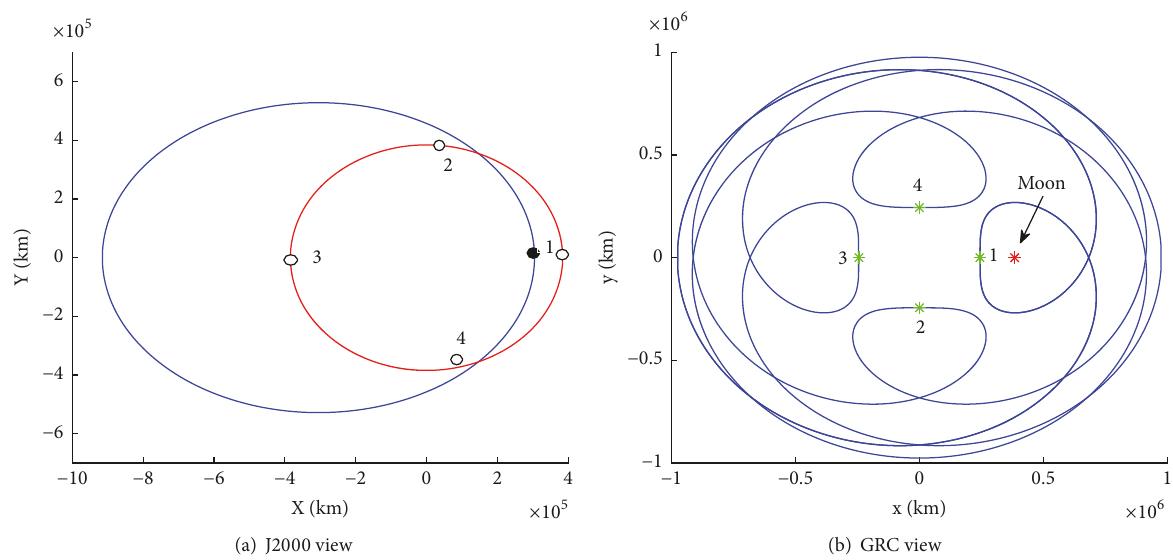
Figure 4: J2000 and GRC views of spacecraft in a 1:2 resonance ( e = 0.6) with the Moon. The four initial phases between the Moon and spacecraft are 𝜃 0 = 0 ∘ , 90 ∘ , 180 ∘ , and 270 ∘